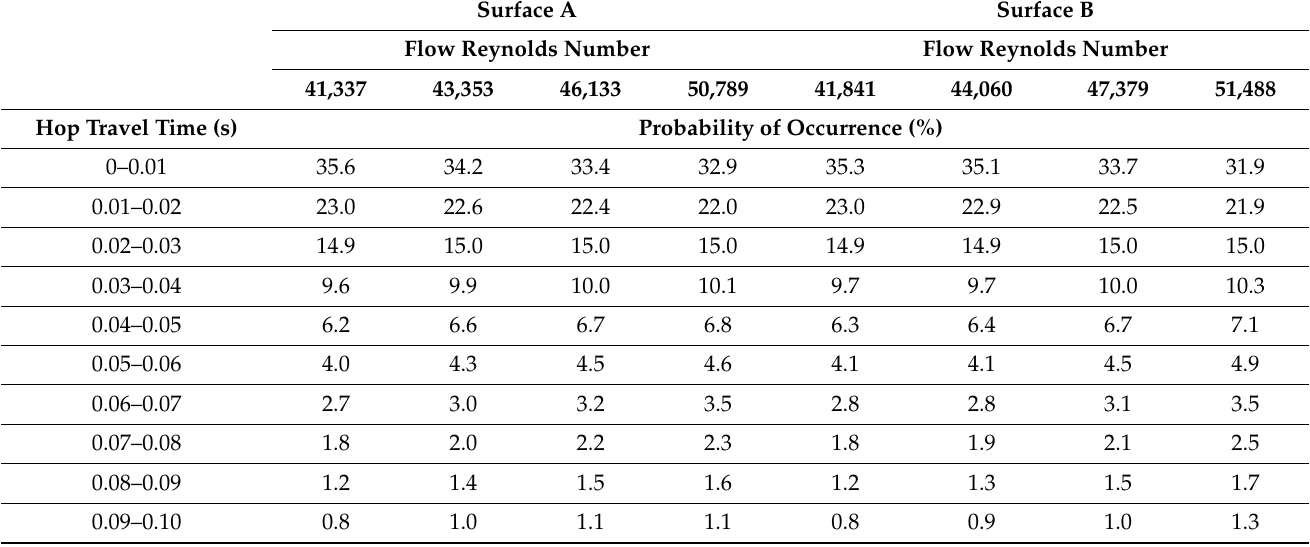
Table A4. The effect of different flow Reynolds numbers on the travel time exponential distribution model parameters, for bed surfaces A and B, for fixed particle density of 1132 kg/m 3 . These tabulated data correspond to the results plotted in Figure